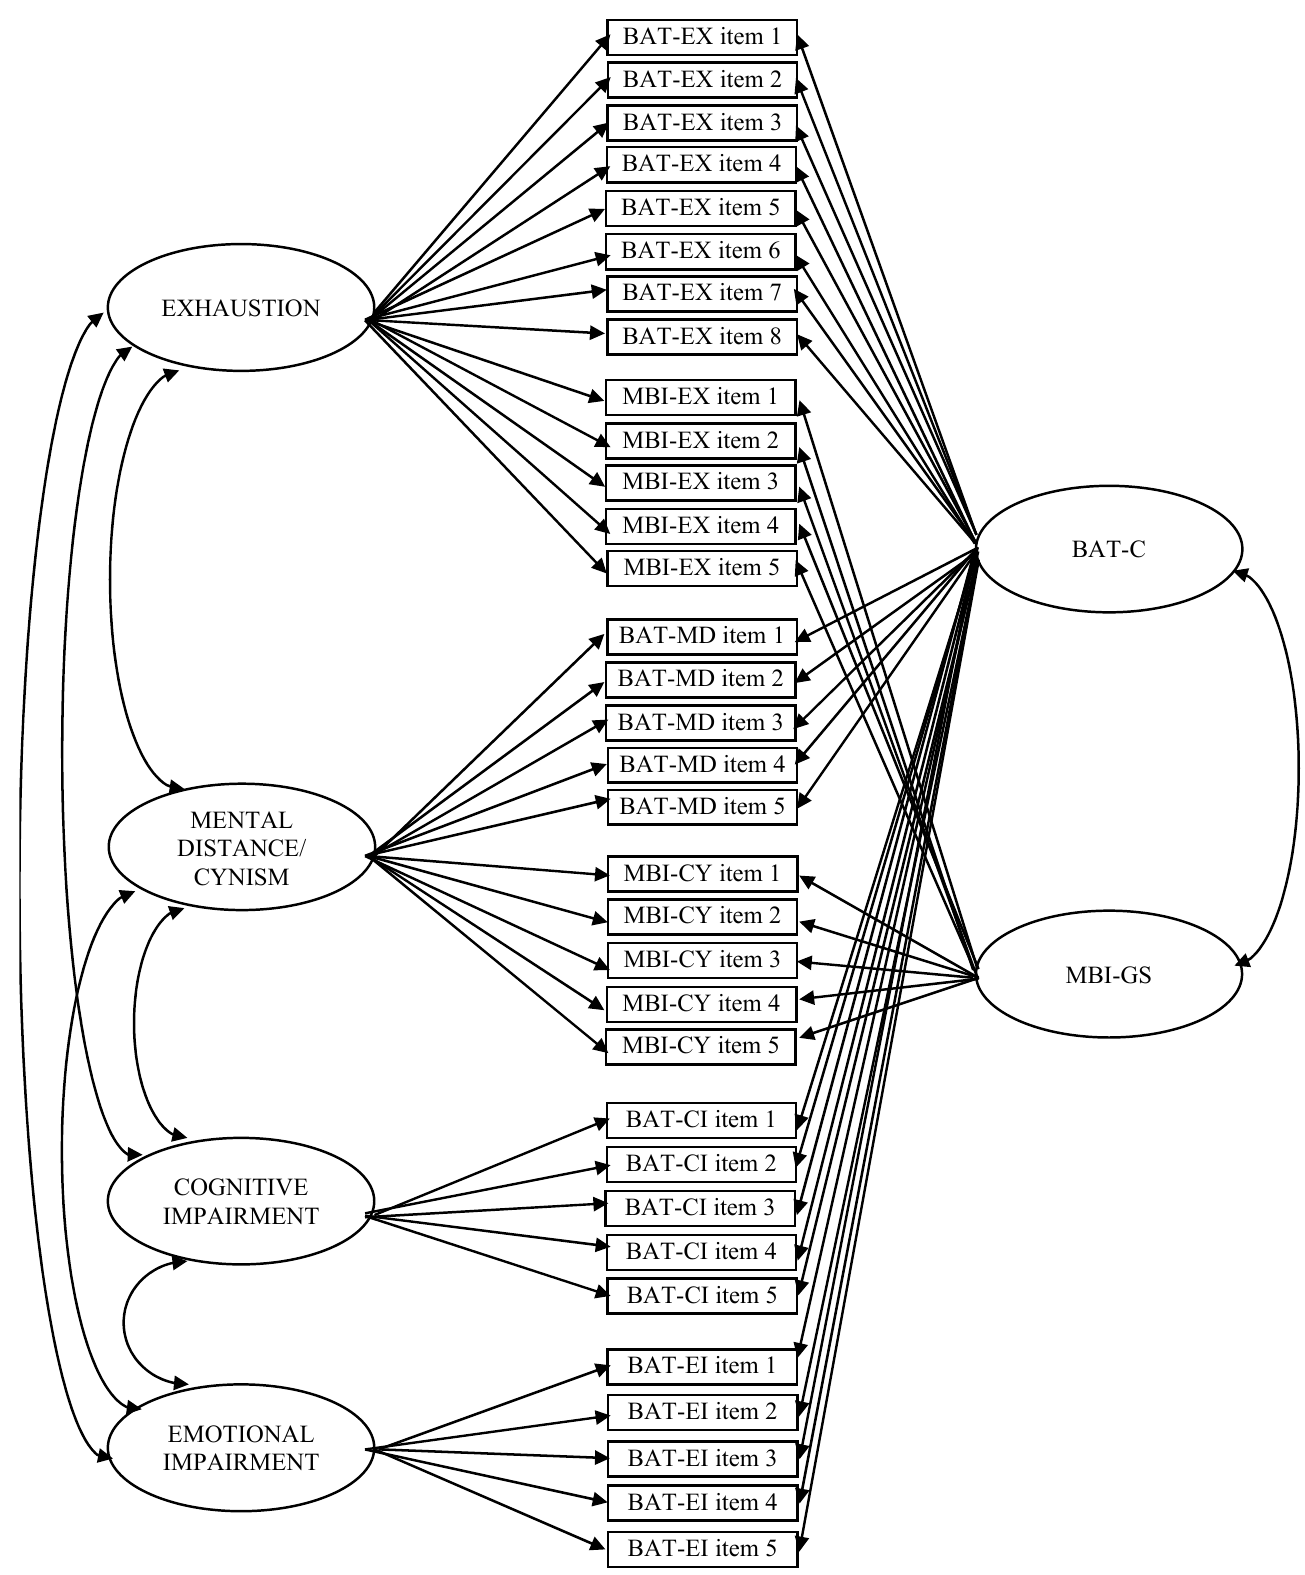
Figure 1 . Correlated traits–correlated methods (CT-CM) model for the Burnout Assessment Tool—Core (BAT-C) and the Maslach Burnout Inventory-General Survey (MBI-GS). Note. EX = Exhaustion; MD = Mental Distance; CY = Cynicism; CI = Cognitive Impairment; EI = Emotional Impairment.